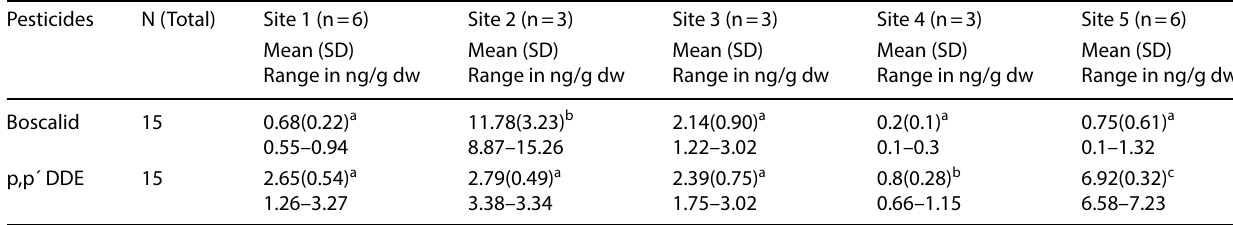
Table 3 Comparison of the mean concentration of boscalid and p,p´ DDE in the sediment of Lake Ziway at different sampling sites